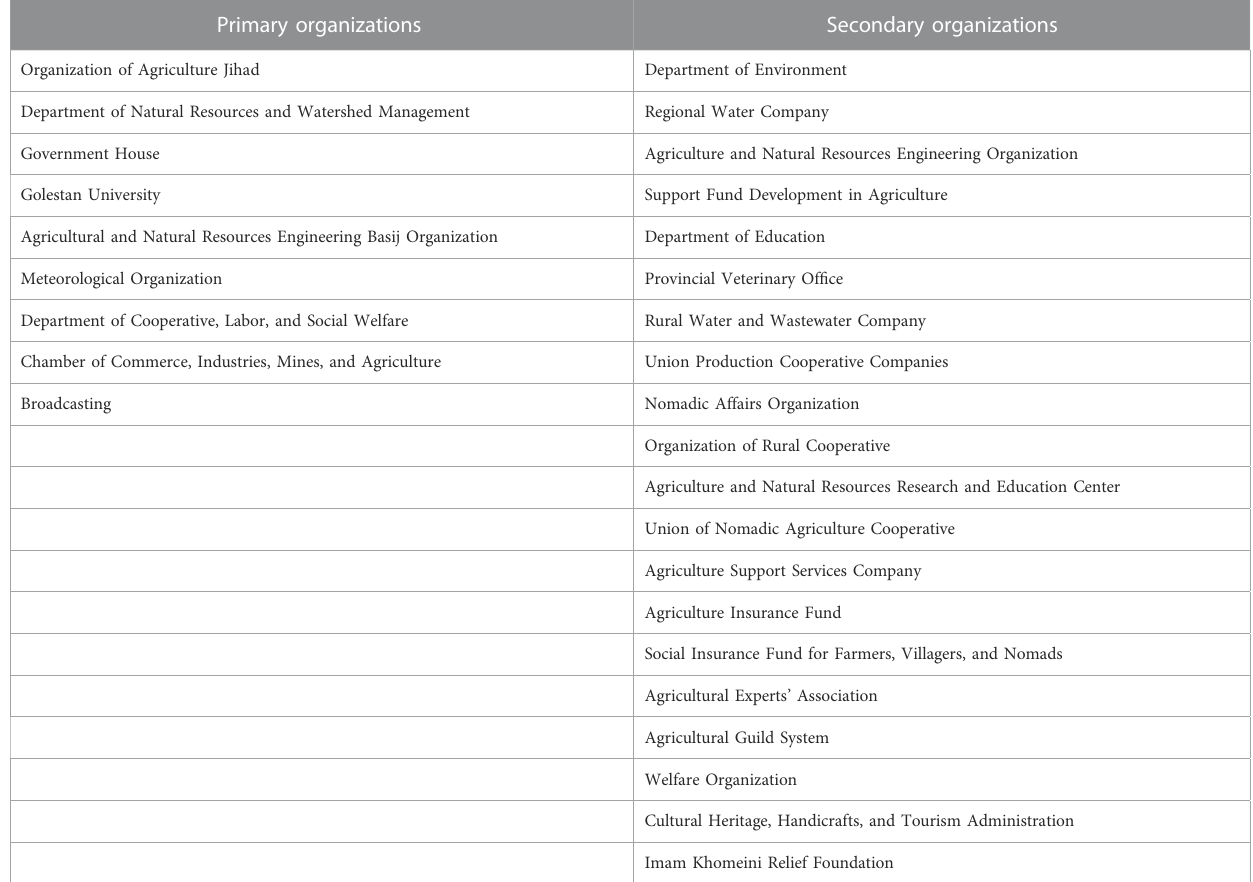
TABLE 7 Primary and secondary organizations in terms of participation in watershed management. Primary